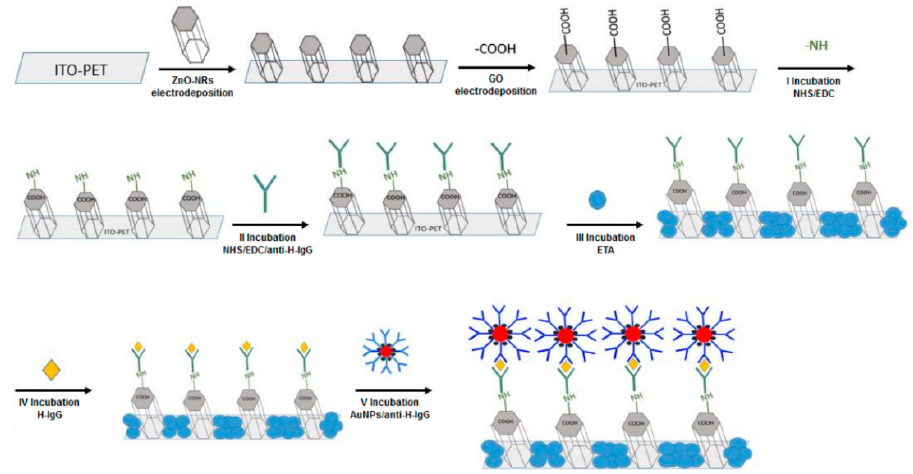
Figure 4. Scheme of the fabrication of immunosensor with a sandwich configuration based on ZnO nanorods. Adapted from [67].